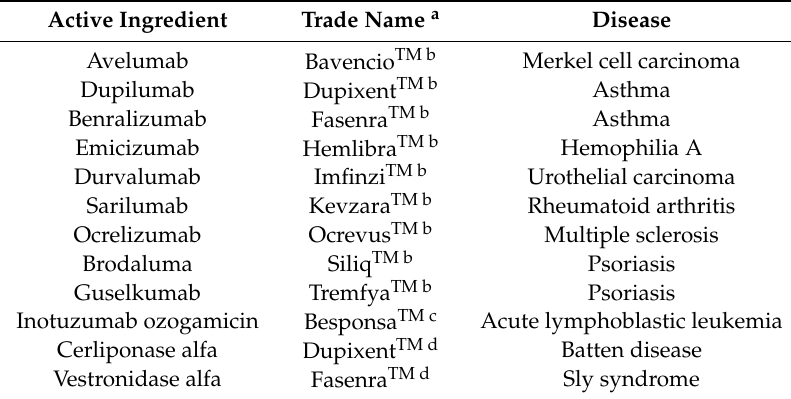
Figure 1. New Chemical Entities and Biologics approved by the FDA in the last two decades [1,2]. Table 1. Biologics approved by the FDA in 2017 [1].